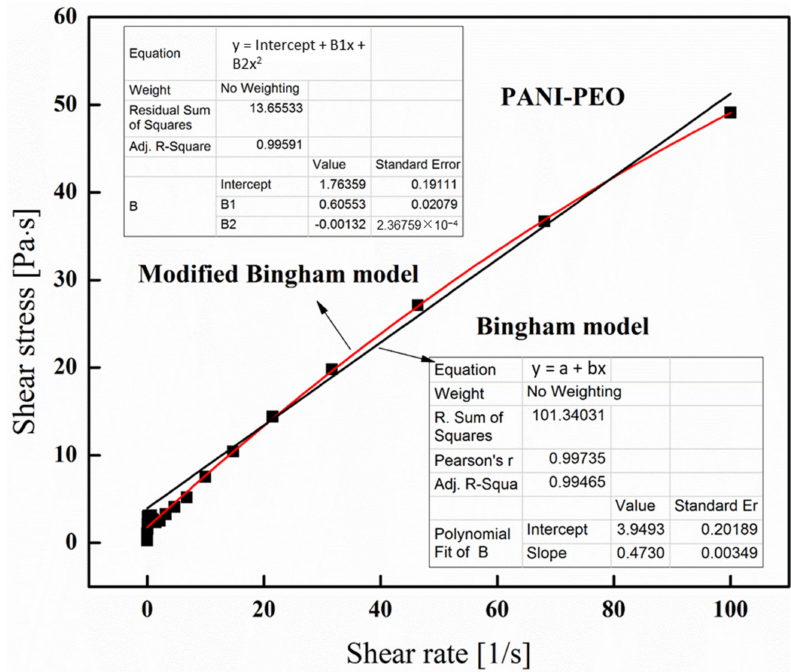
Figure 11. Bingham and modified Bingham models for PANI-PEO blend at room temperature.